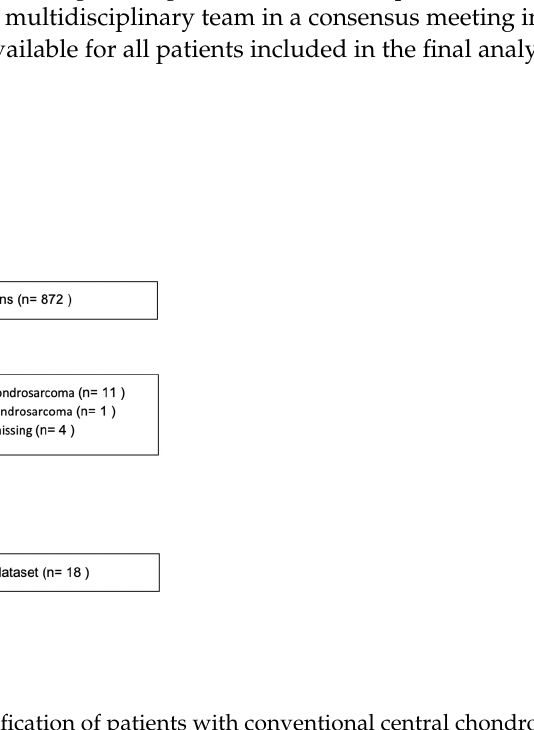
Figure 1. Flowchart of identification of patients with conventional central chondrosarcomas of the proximal humerus. The primary outcome measure was LRFS, and the secondary outcome measures were predictors of LR and DSS.